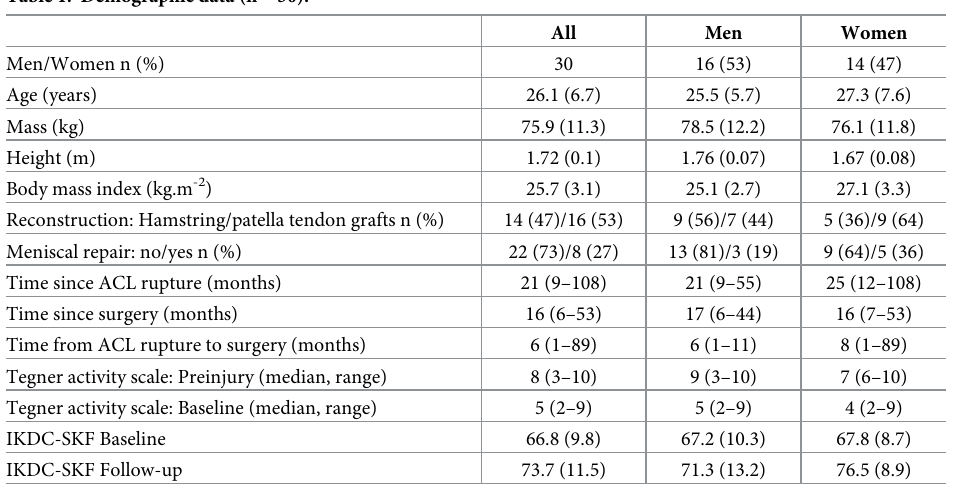
Table 1. Demographic data (n = 30).